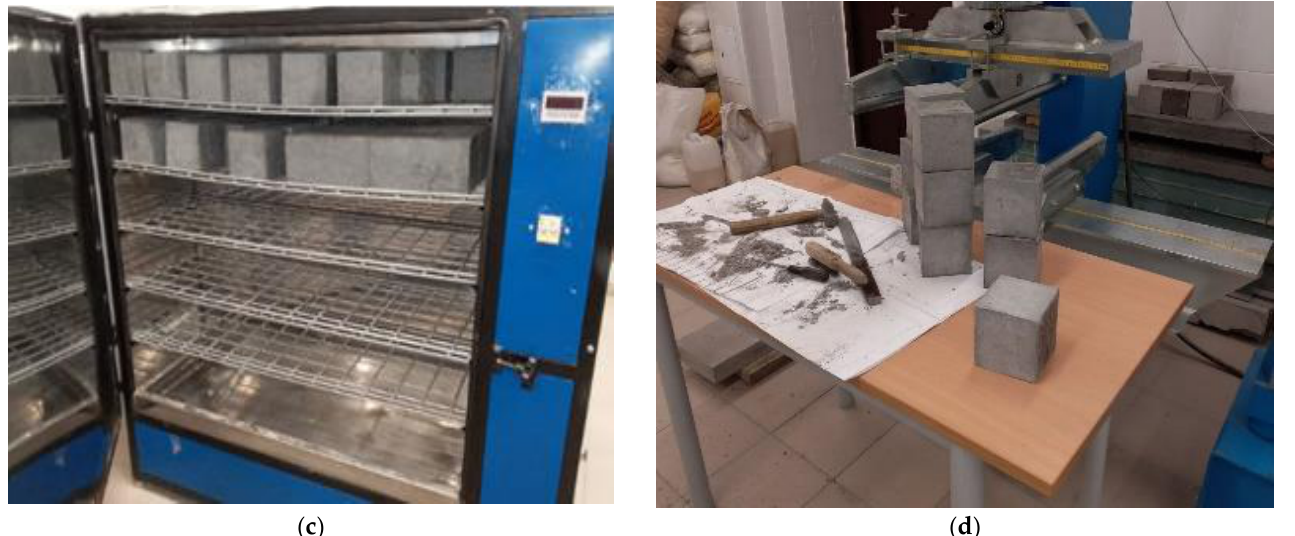
Figure 5. Mixing design devices: ( a ) Pan Mixer; ( b ) Concrete formwork; ( c ) Moist Cabinet; ( d ) clean- ing method.